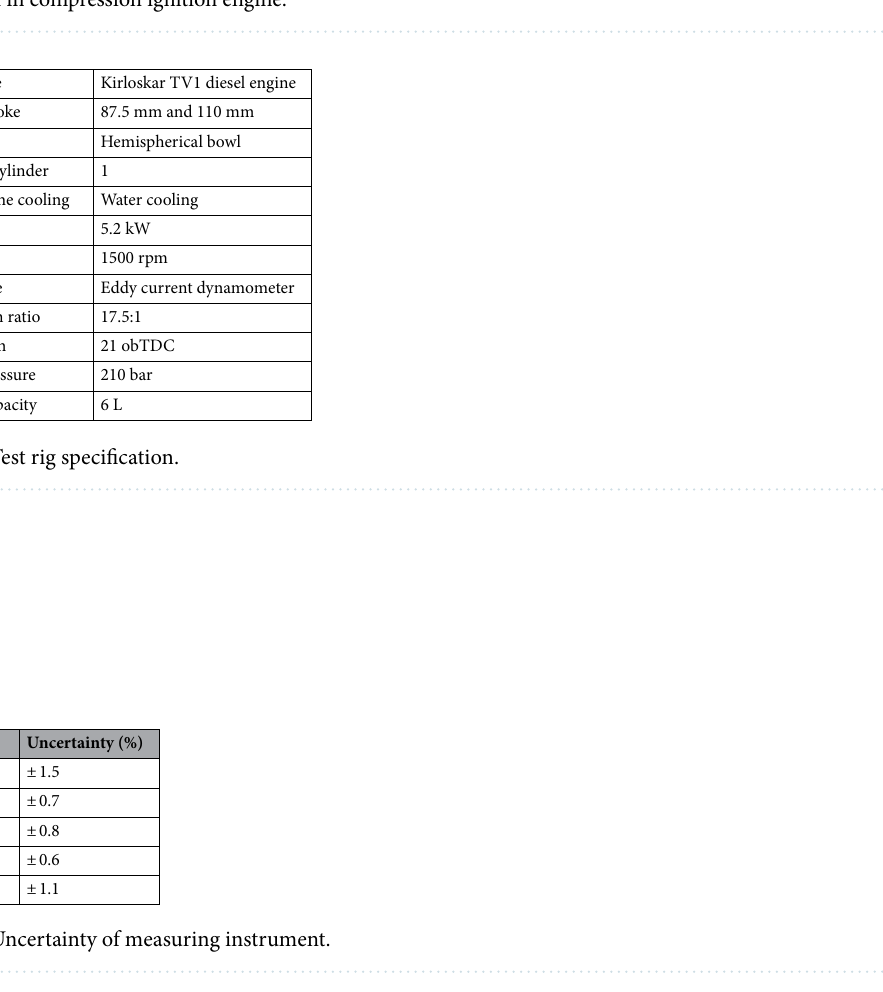
Figure 2. Schematic diagram on the production of waste fish oil through transesterification process and its application in compression ignition engine.